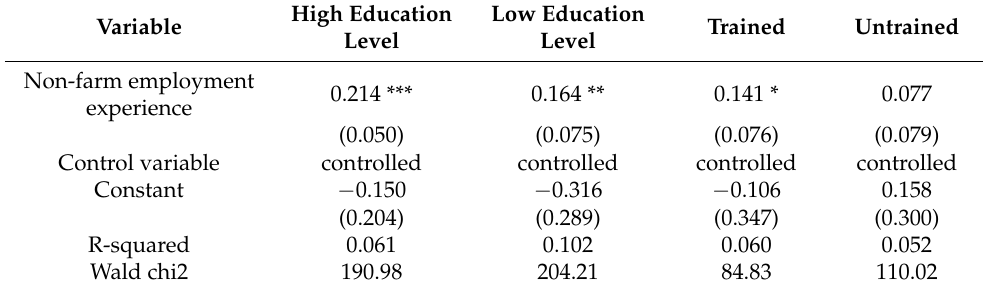
Table 6. Heterogeneity